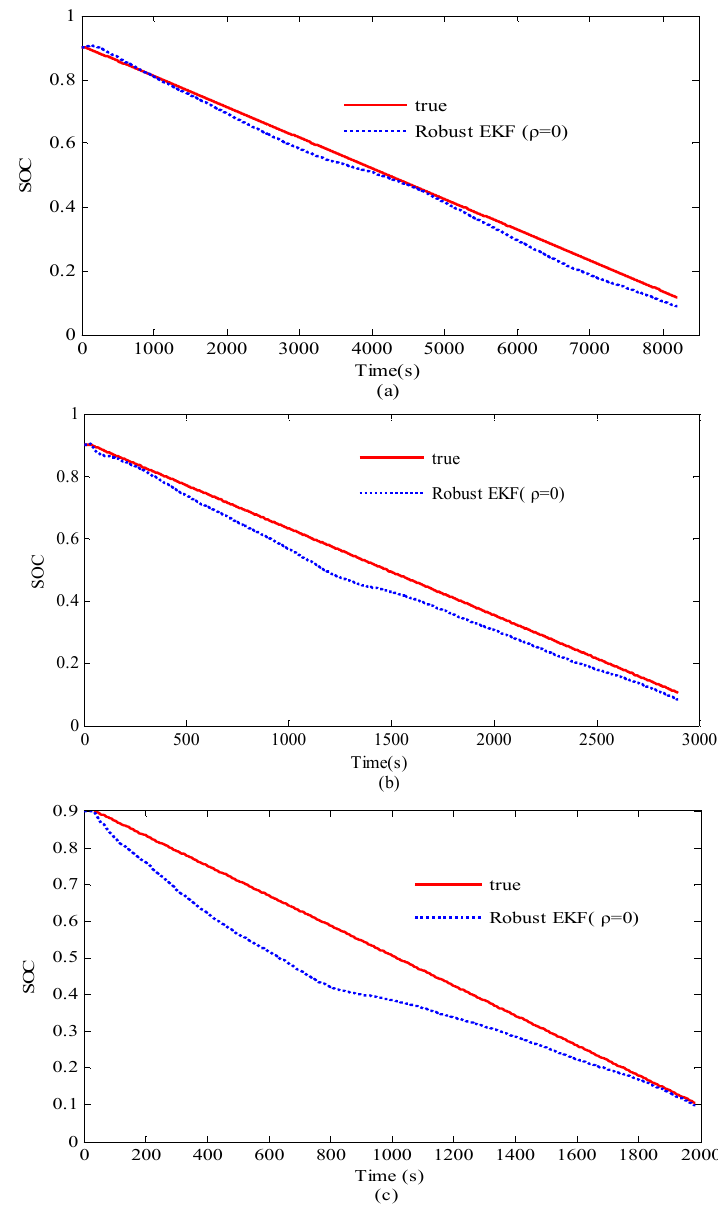
Figure 5. The experimental and estimated SOC of the battery with Robust EKF at ρ = 0 (SOC = 0